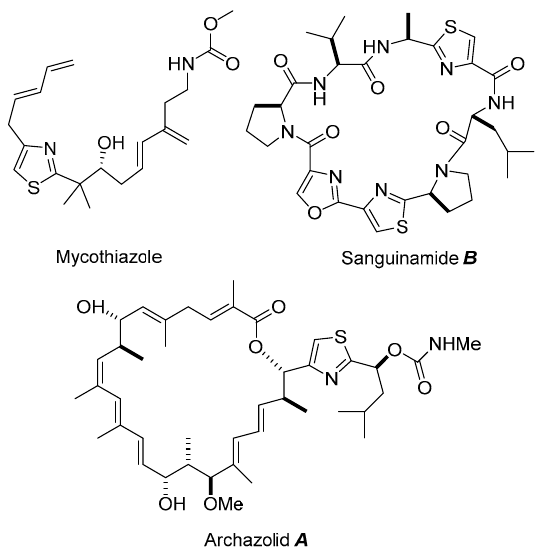
Figure 1. The structure of mycothiazole, sanguinamide B , and archazolid A .